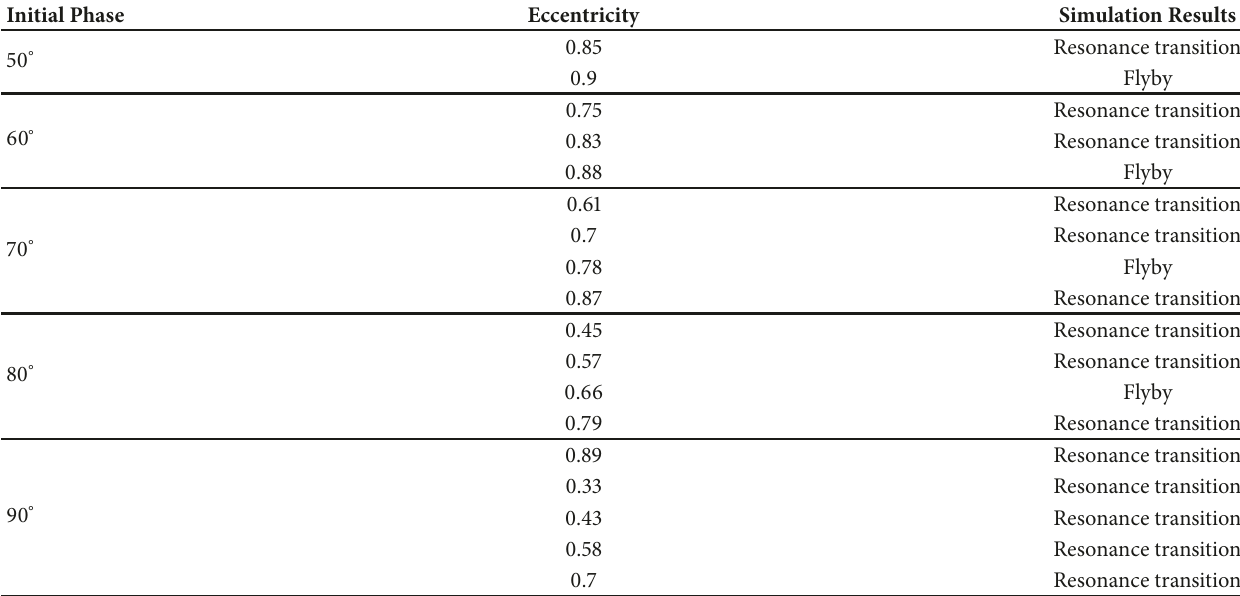
Table 5: Simulation results for 2:1 resonant orbits when the initial parameters can cause the closest distance to lie within the Moon’s sphere of